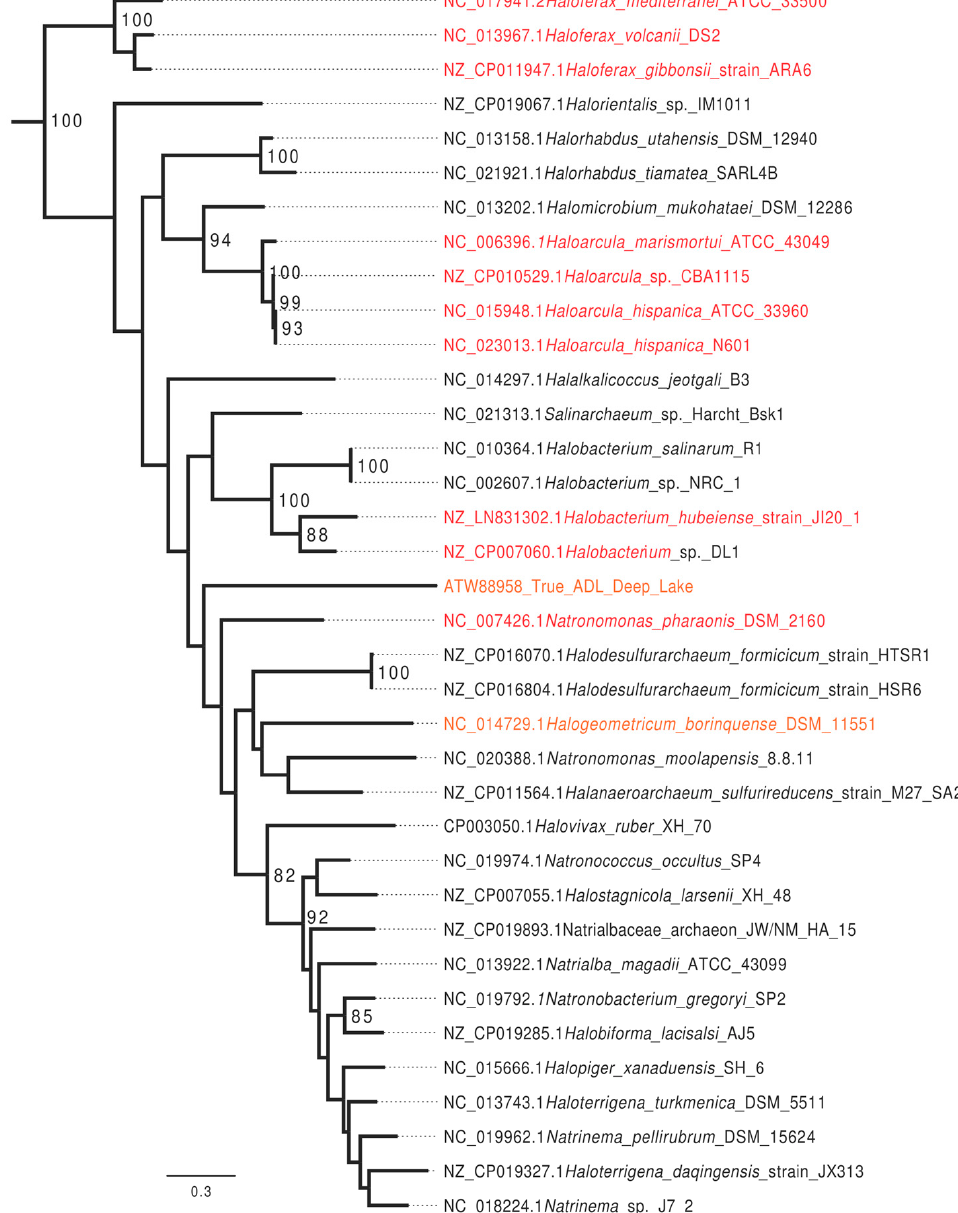
Figure 2. Maximum likelihood phylogeny of homologs of the Haloferax volcanii DS2 CTAG MTase identified in completely sequenced haloarchaeal genomes. Numbers give non-parametric bootstrap support values. The phylogeny was rooted using more divergent haloarchaeal and methanomicrobial homologs. Genomes with a chromosome wide GATC to CTAG ratio below five are given in red, those with a GATC to CTAG ratio between 5 and 14 are given in orange. In addition, those with a ratio above 20 are given in black. Note that only few groups are well supported, including the Haloferax and Haloarcula genera.